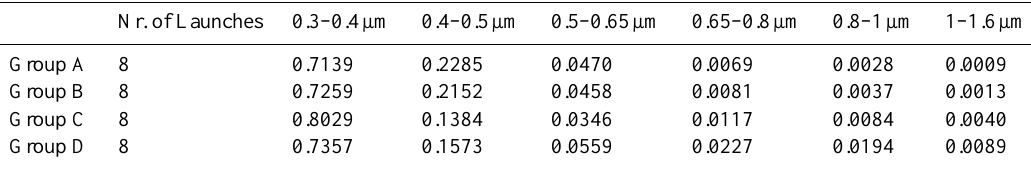
Table 7. Average size distribution in homogeneous sub-groups included in model